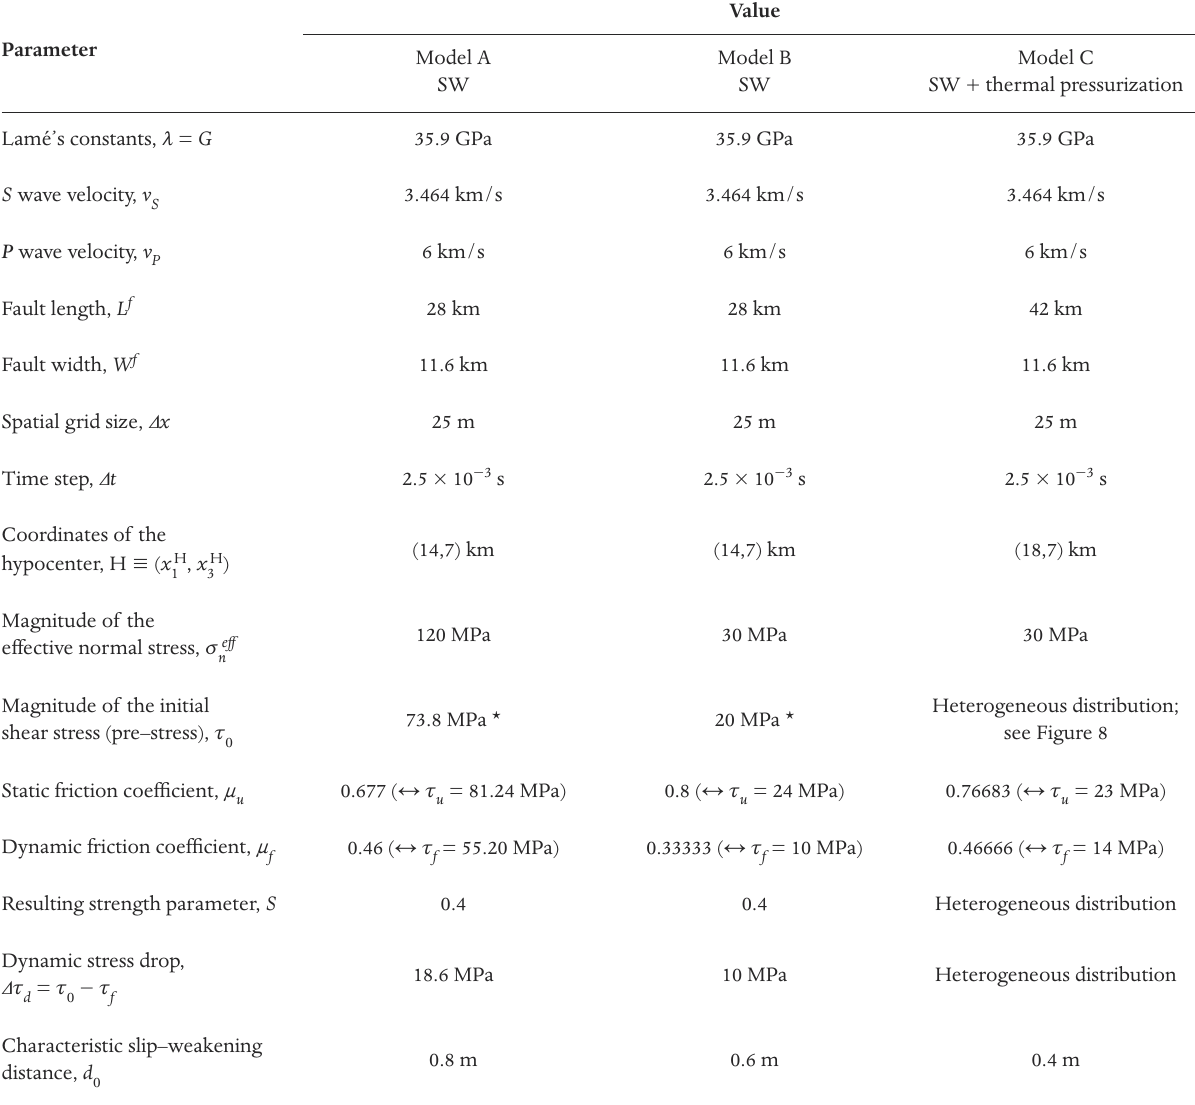
–component of the initial shear traction vector T is non 1